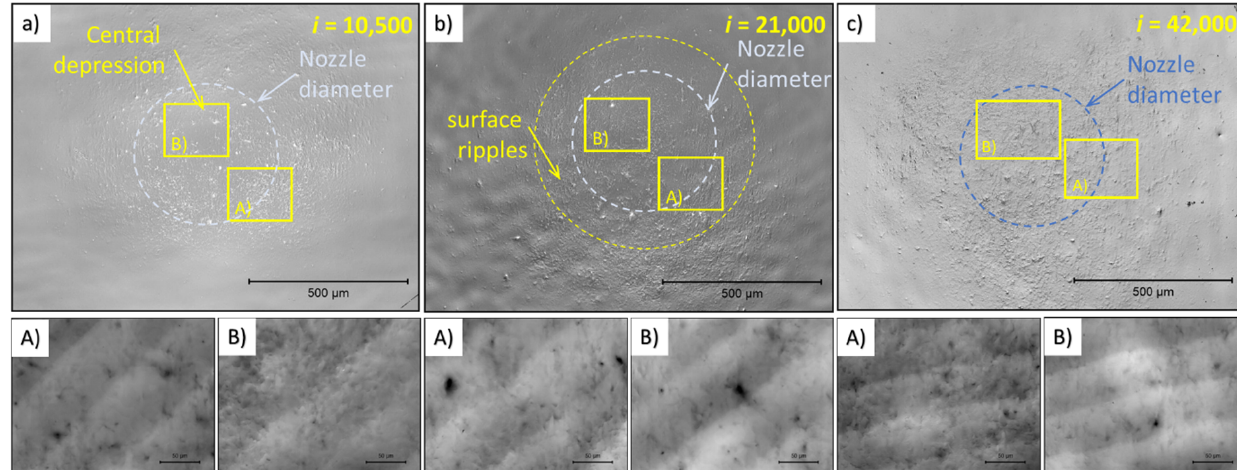
Figure 4. Results of confocal microscopy showing the evolution of erosion damage to the polished surface of titanium with increasing the cumulative impingements ( a ) is 10,500 impingements, ( b ) is 21,000 impingements and ( c ) is 42,impingements. The impingements are from a stationary source using an ultrasonic pulsating water jet with an impact velocity of 150 m/s and water cluster diameter d of 0.4 mm, indicated by the dashed line.